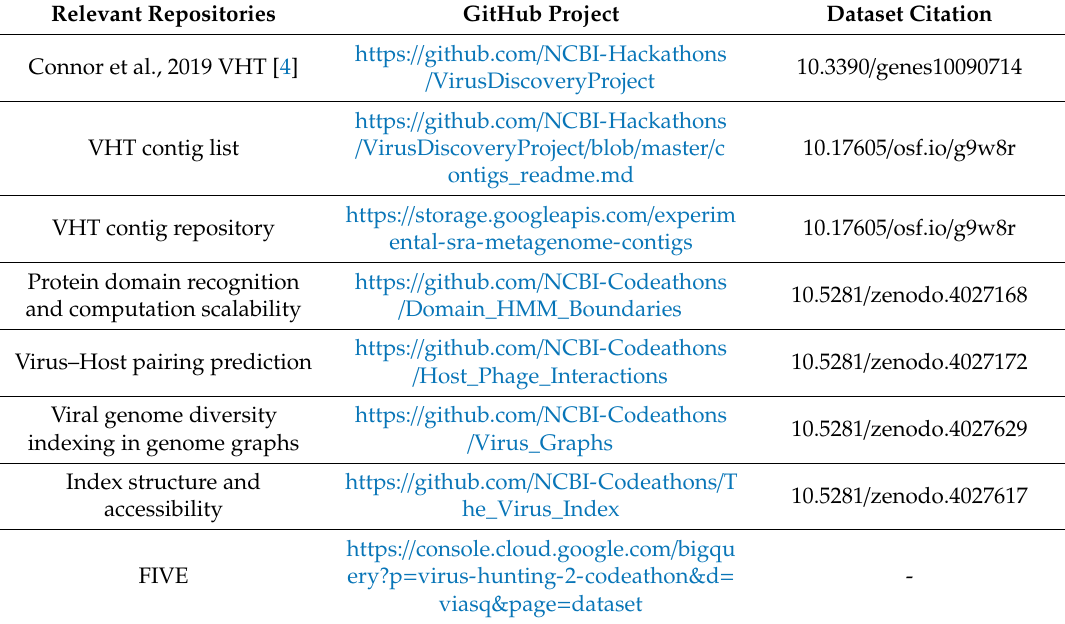
Table 1. List of repositories used in the generation of FIVE and its accessory information (contigs and FIVE link) hosted in GitHub and the first release of each repository frozen in ZENODO. VHT—Virus Hunting